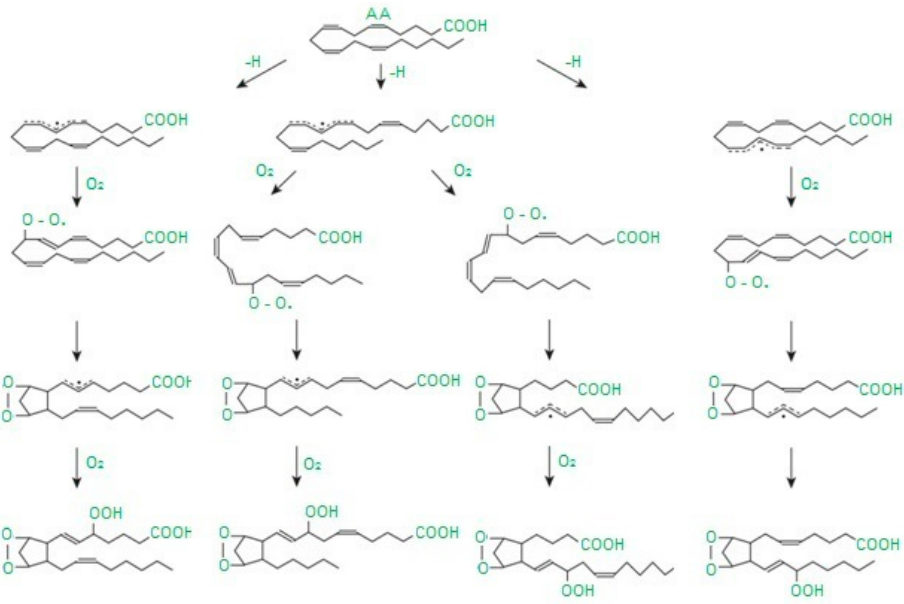
Figure 2. Abbreviation: AA—arachidonic acid. Diagram of isoprostane formation according to [37] as modified by the authors.